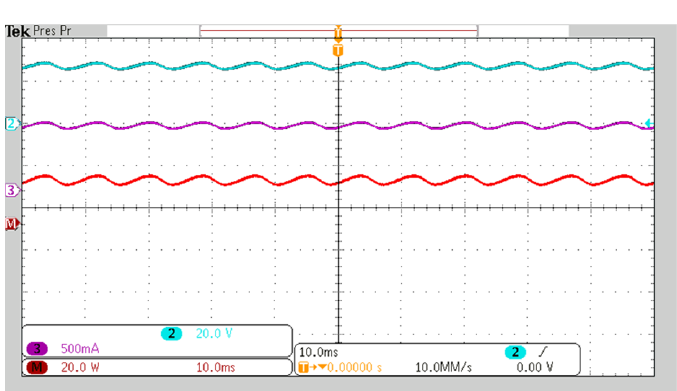
Figure 19. Waveforms: output voltage (blue, 20 V/div), output current (purple, 500 mA/div), and output power (orange, 20 W/div).